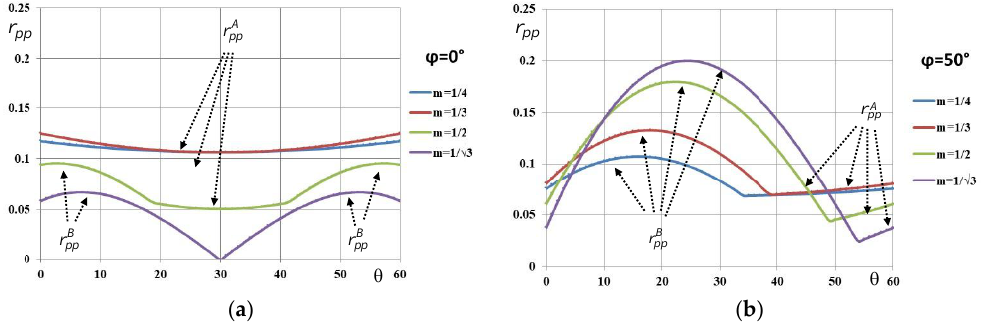
Figure 4. Normalized peak-to-peak dc-link voltage ripple amplitude r pp ( ϑ ) over the period [0, 60 ◦ ] for different modulation indices, m = 1/4, 1/3, 1/2 and 1/ 3, and output phase angles ( a ) ϕ = 0 ◦ and ( b ) 50 ◦.